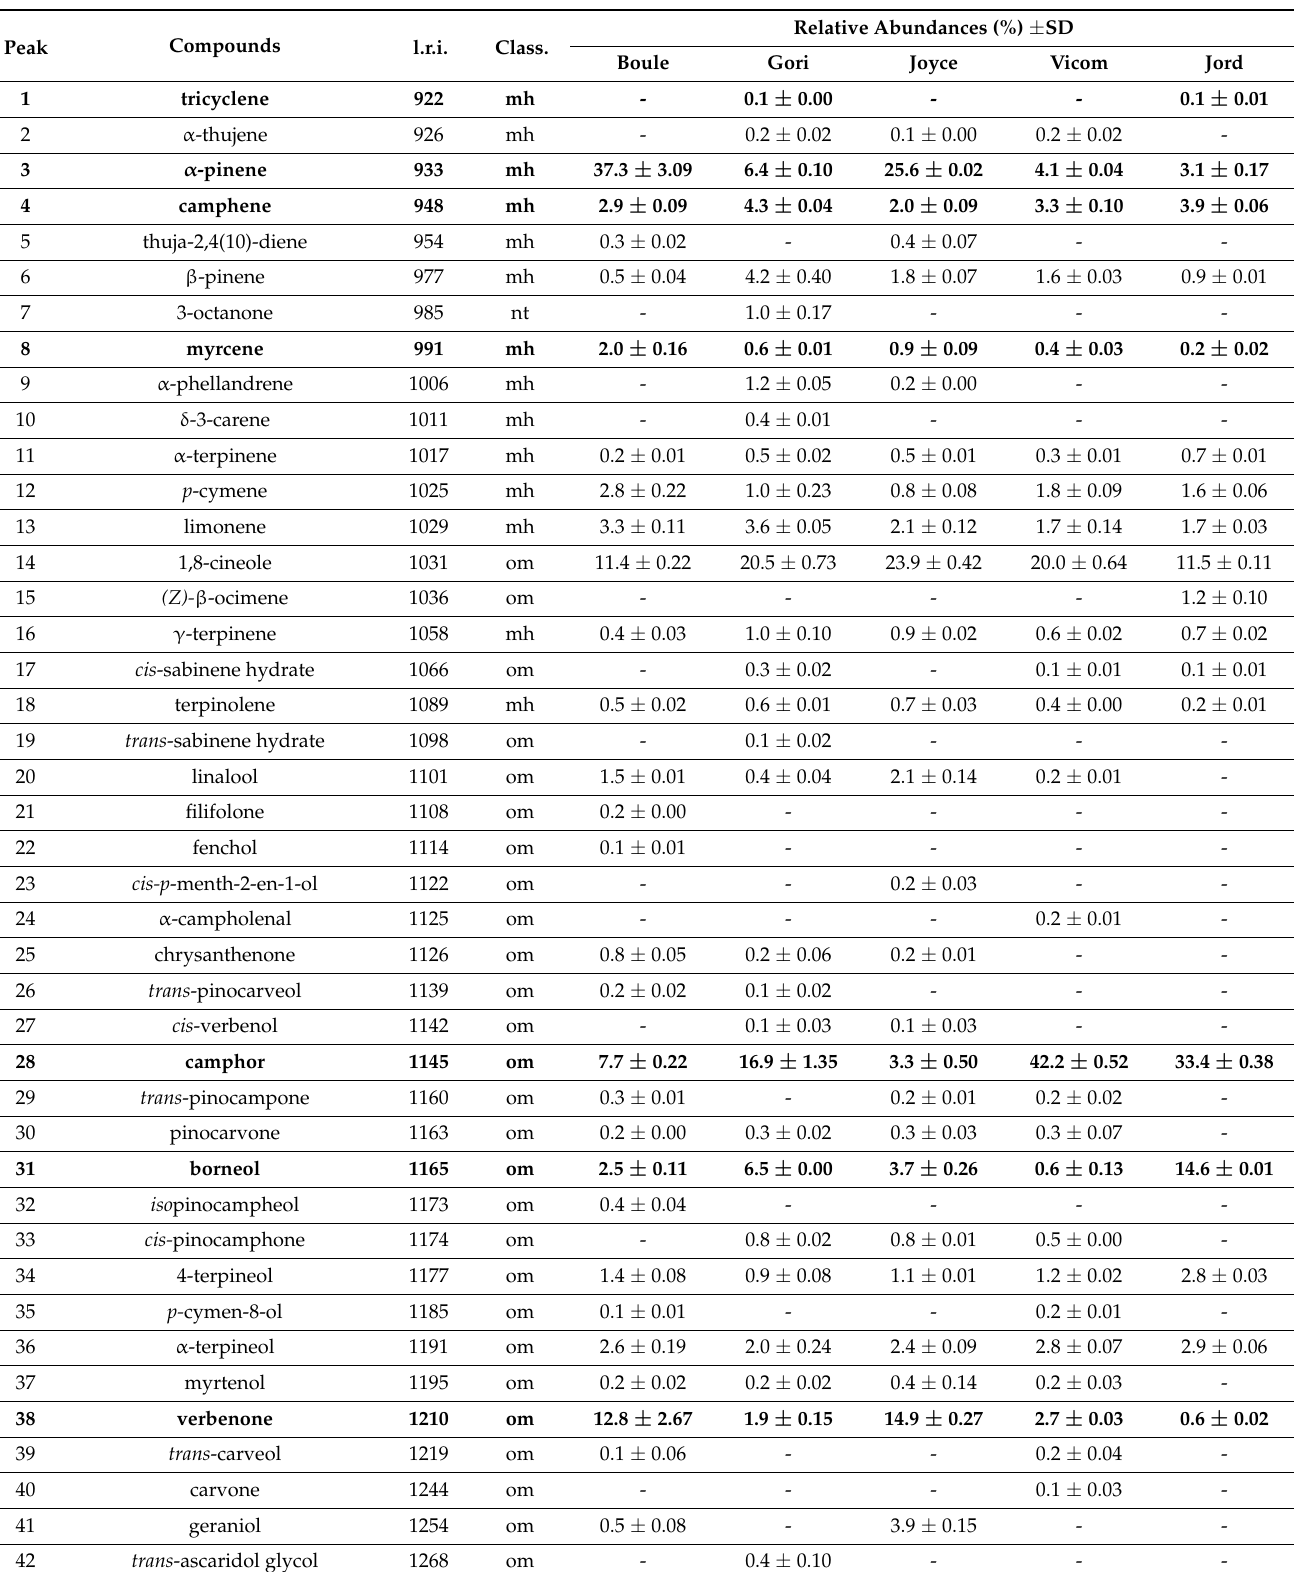
Table 1. Complete composition and extraction yield (% w/w dry weight) of the essential oil obtained from the samples of S. rosmarinus and S. jordanii